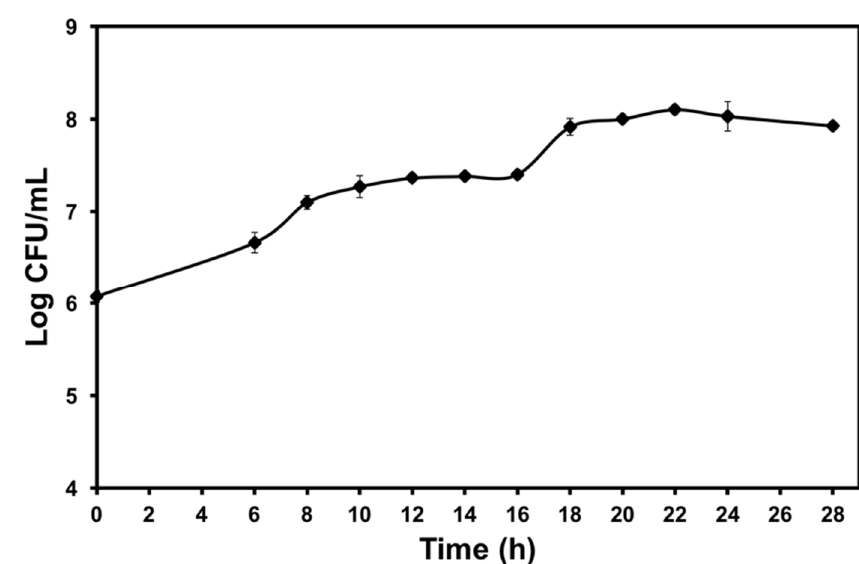
Figure 1. A growth profile of P. polymyxa Kp10 based on colony-forming unit (CFU)/mL ( ♦ ) during 28 h of the incubation period. The error bars represent the standard deviations about the mean ( n = 3).